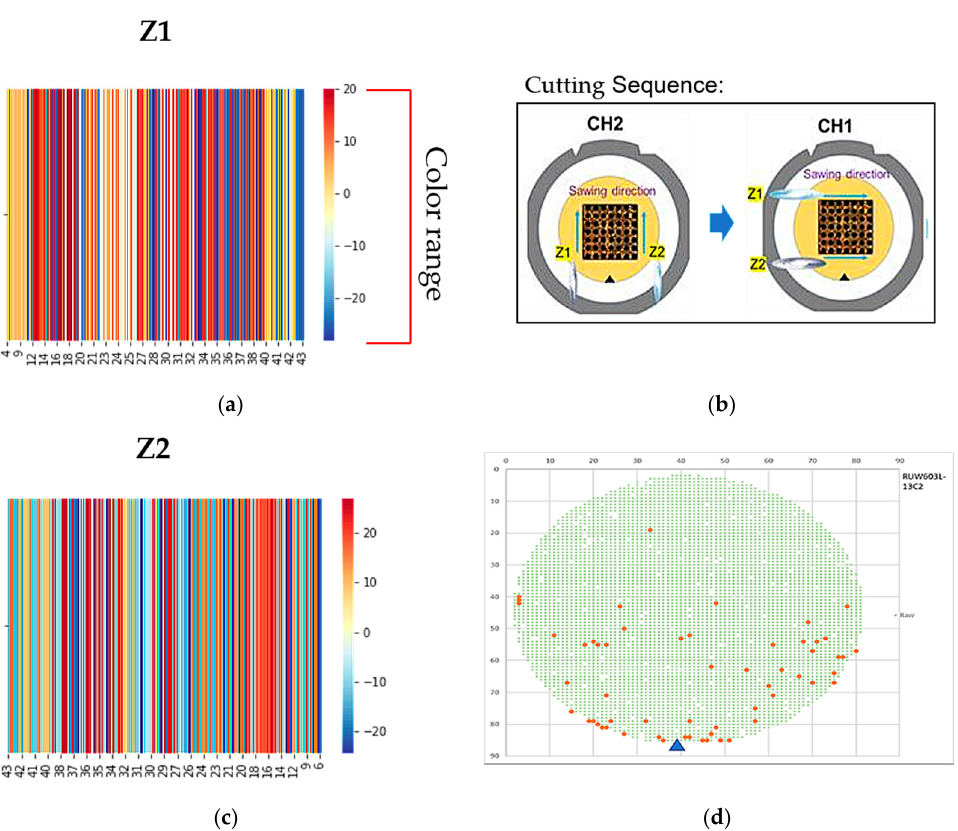
Figure 18. Heat map after Barnes-Hut t-SNE dimensionality reduction where ( a ) Heat map of kerf Z1; ( b ) Cutting Sequence; ( c ) Heat map of kerf Z2 in which arrows represent sawing direction; ( d ) Wafer chipping coordinate of ID: RUW603L_13C2 in CH2 in which a blue triangle represents the kerf Z1 stopped location.